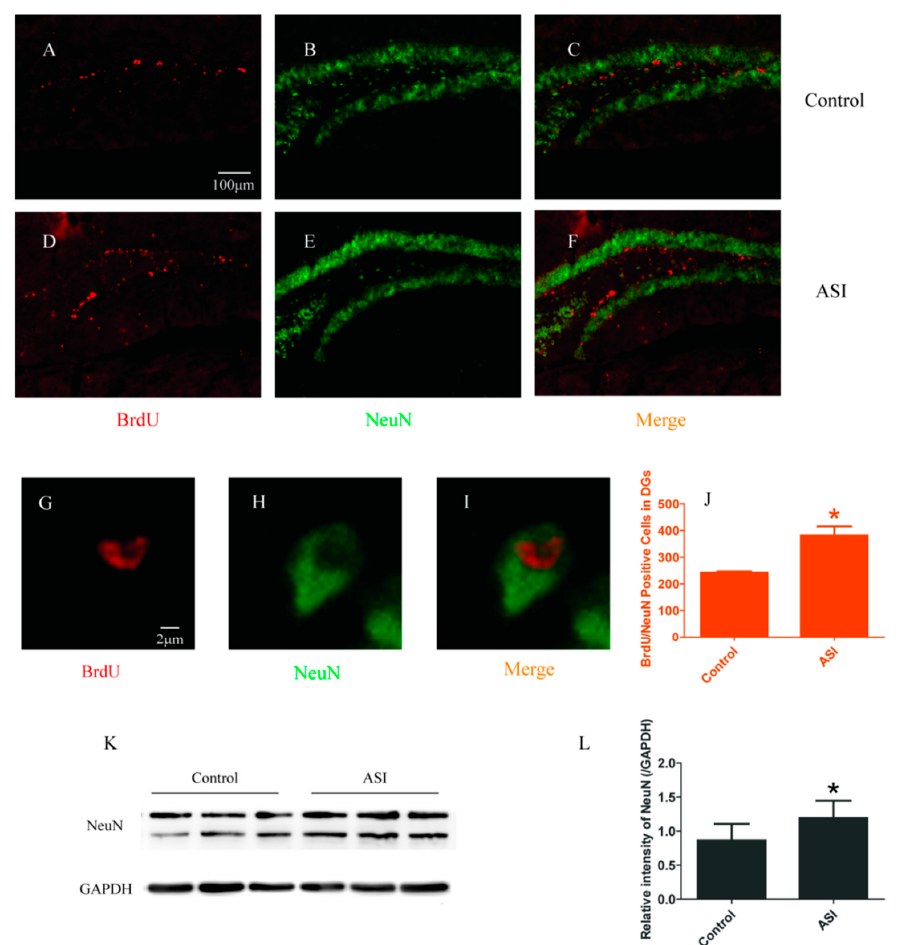
Figure 3. ASI (25 mg/kg) increased the total number of newly generated neurons (BrdU + /NeuN + ). ( A – I ) Confocal images of BrdU (red) and NeuN (green) immunostaining: ( A – C ) Control group; ( D – F ) ASI group; and ( G – I ) enlarged images of the cells from ASI group. ( A – F ) Scale bar = 100 µ m. ( G – I ) Scale bar = 2 µ m. ( J ) Quantification of BrdU + /NeuN + double immunopositive cells in two groups ( n = 4/group). ( K ) Western blotting analysis of NeuN in hippocampus. ( L ) Gray intensity analysis of NeuN in hippocampus ( n = 8/group). * p < 0.05. The data are presented as mean ± SD.